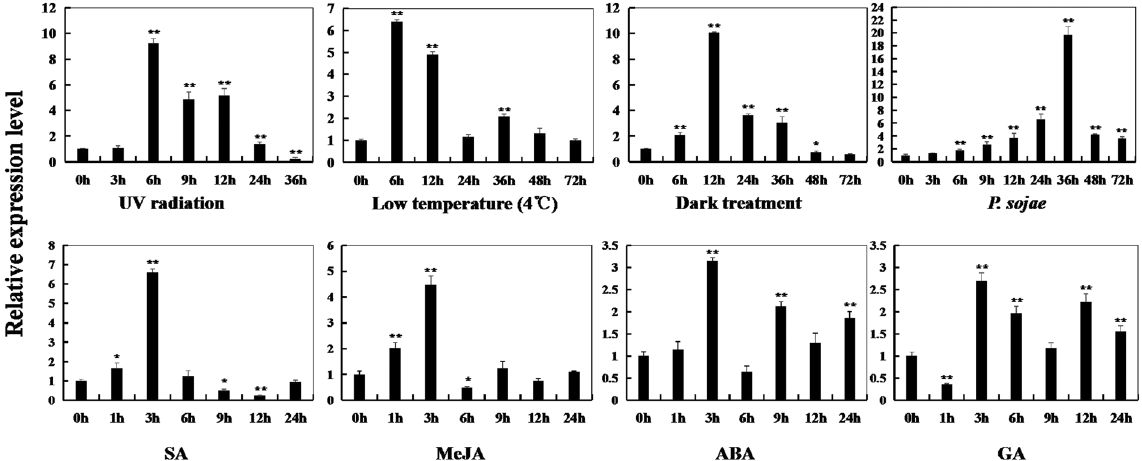
Figure 1. The relative transcript levels of GmPAL2 . 1 at various time points post-treatment with SA, MeJA, ABA, GA, UV radiation, low temperature (4 °C), darkness and P . sojae ‘Suinong 10’ soybean plants. Fourteen- day-old plants were used for the treatments and analyses. The amplification of the soybean Actin ( GmActin4 ) gene was used as an internal control to normalize all the data. The relative transcript levels of GmPAL2 . 1 were quantified compared with mock plants at the same time points. The experiment was performed on three biological replicates with their respective three technical replicates and statistically analyzed using Student’s t-test ( * P < 0.05; ** P < 0.01). Bars indicate the standard error of the mean.